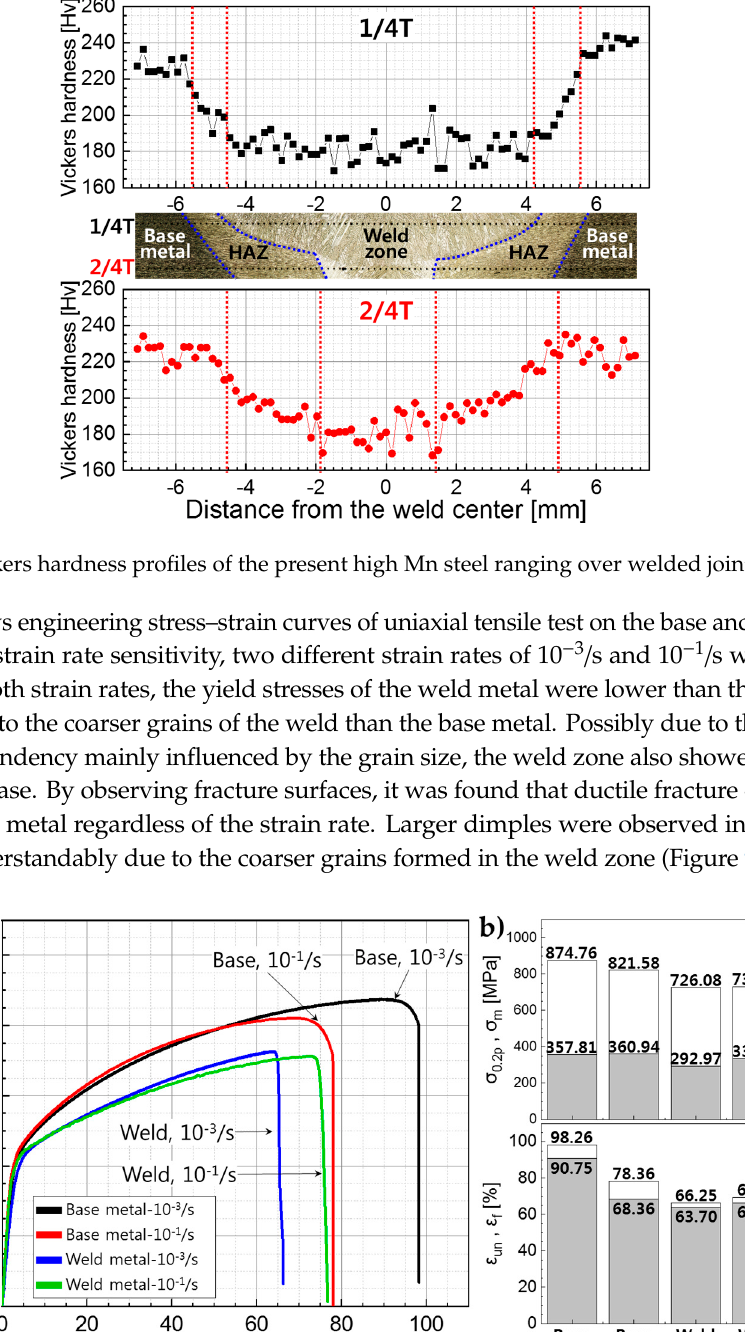
Figure 6. EBSD analysis results of the as-welded steel: ( a ) phase map, ( b – d ) inverse pole figure (IPF) maps at rolling direction, transverse direction, and normal direction, respectively.